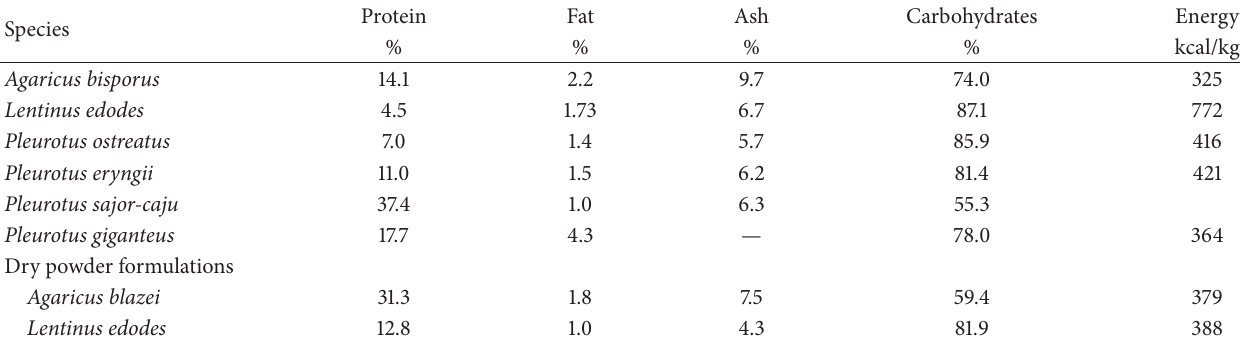
Table 1: Proximal composition of some edible mushrooms (dry basis).